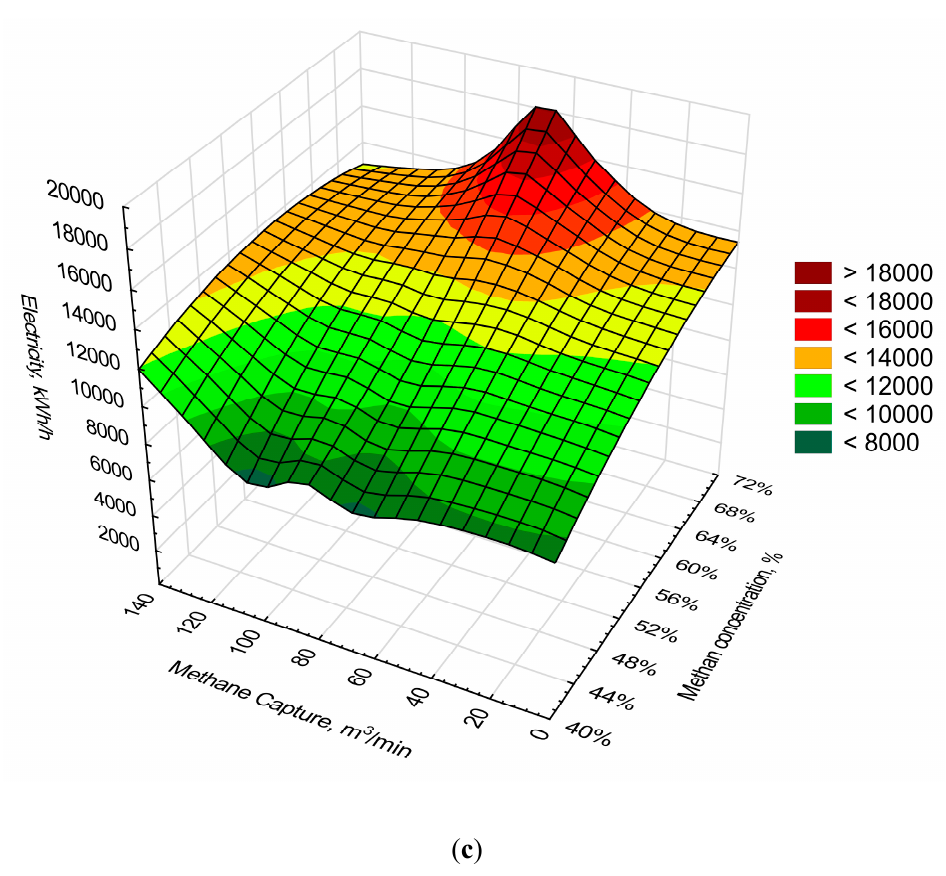
Figure 11. Dependence of electricity production in the function ( a ) methane concentration, ( b ) methane capture, and ( c ) methane capture and methane concentration.